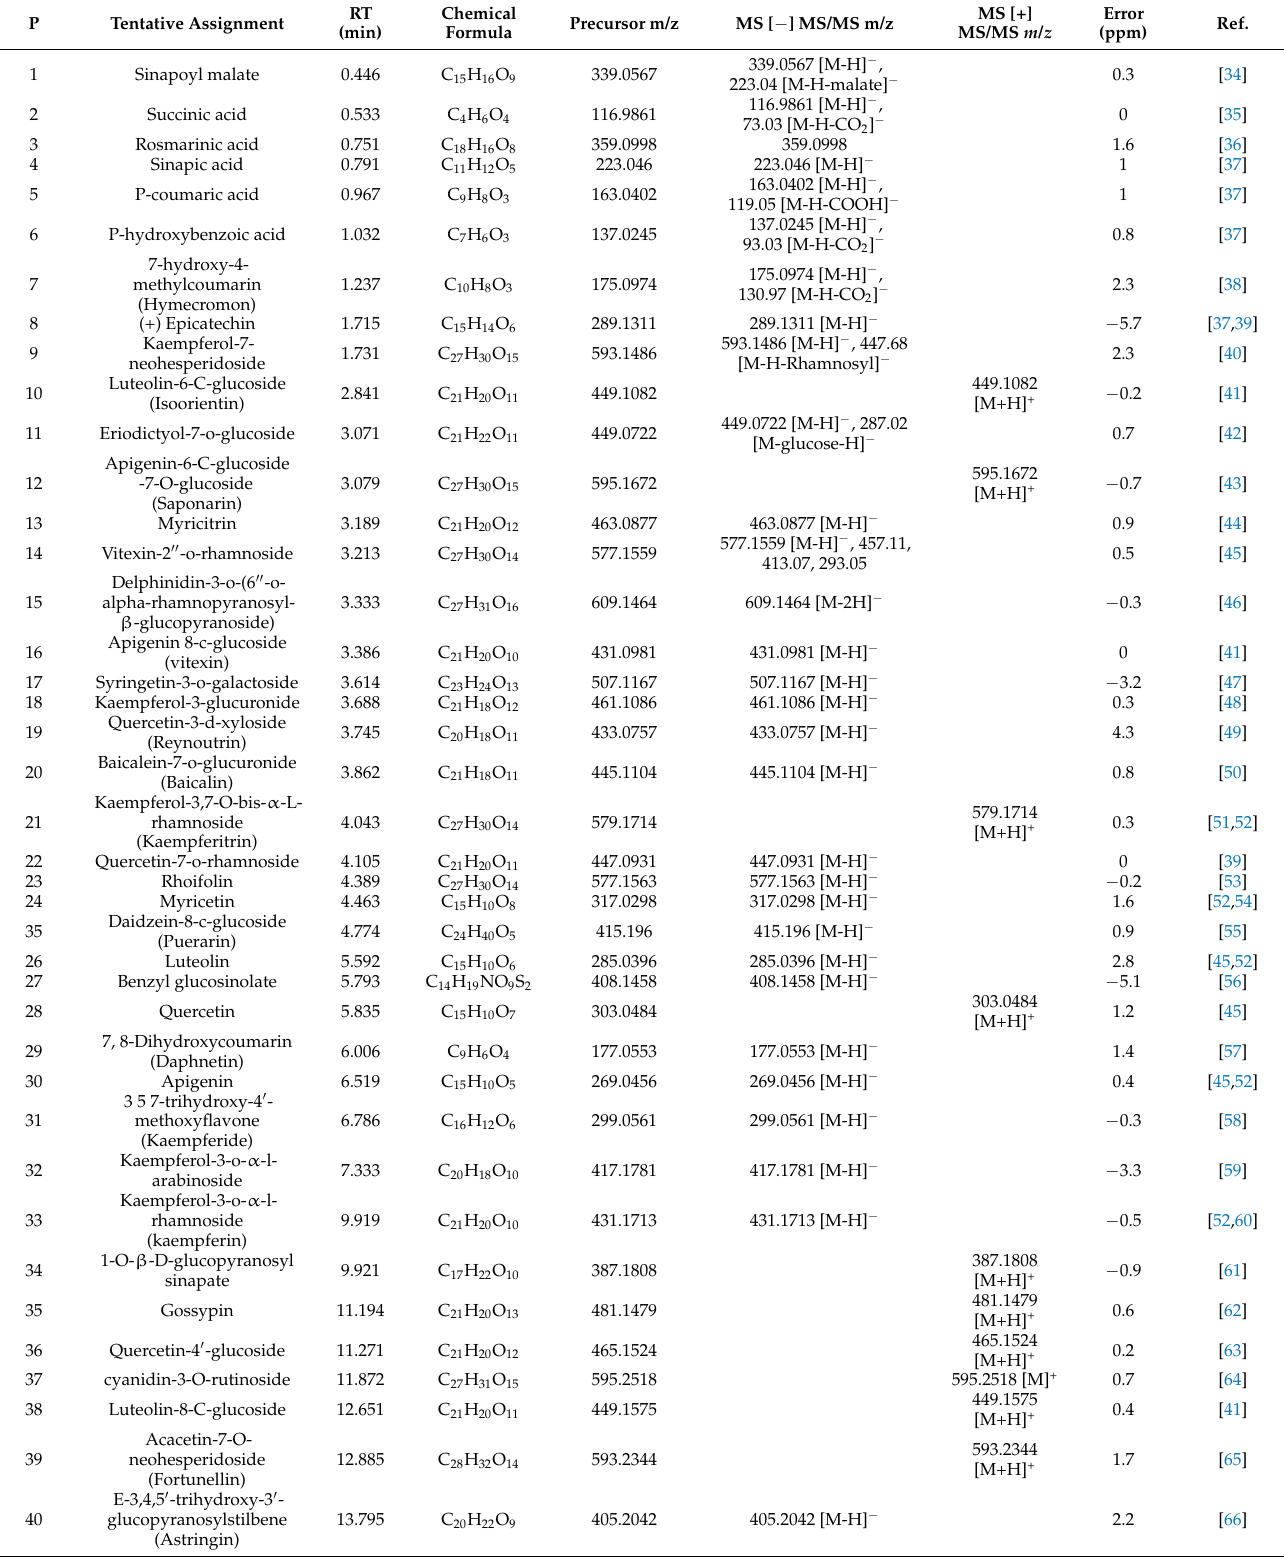
Table 4. Compounds tentatively identified by mass spectra of S. sieboldii extract,